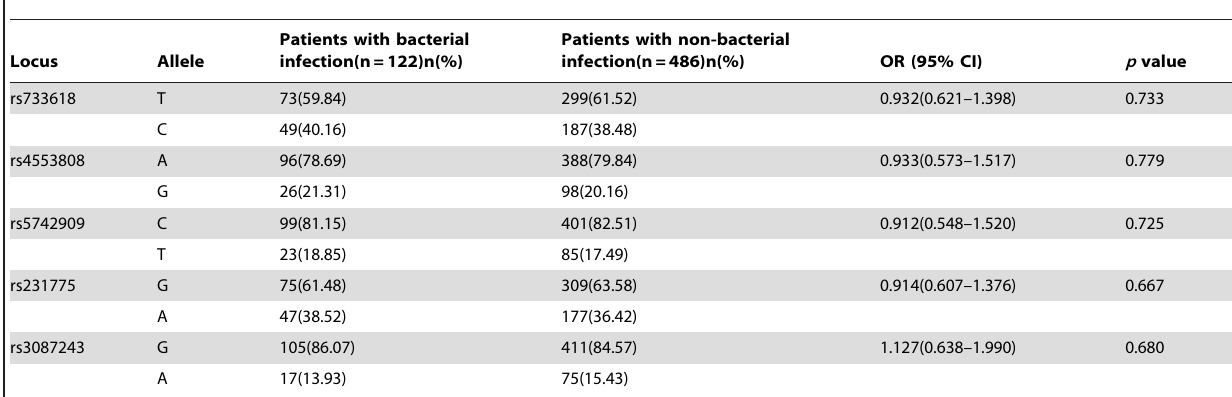
Table 4. The allele distribution of CTLA4 polymorphisms in patients with bacterial infection and non-bacterial infection.